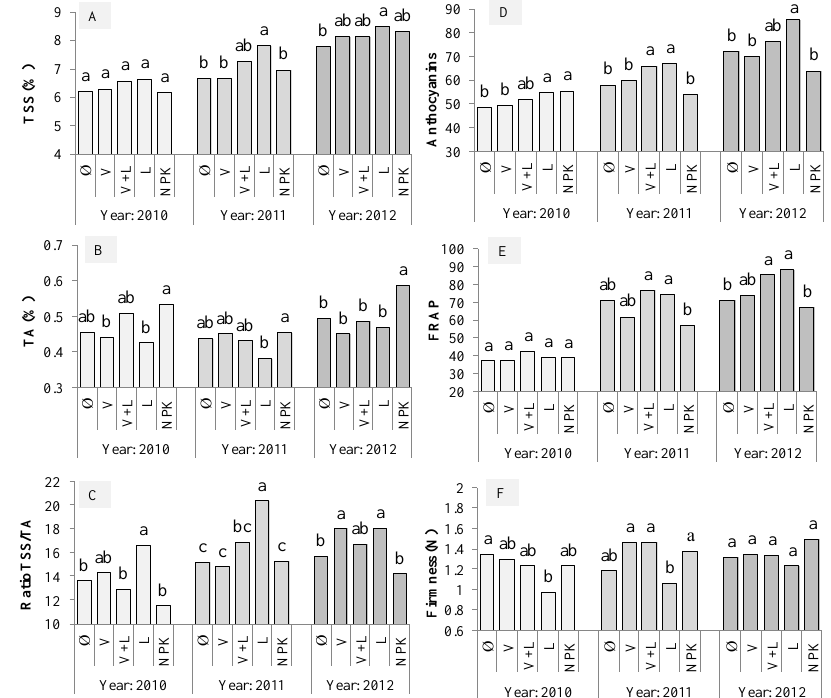
cyanins and antioxidant activity of the fruit (FRAP) not only in the control but also in the NPK treatment. On the other hand, the lowest firmness of strawberry fruit in all three years was measured on the treatment where vermicompost leachate was applied (L treatment). Strawberry fruit quality parameters in treatment V, in all three years of fruiting, did not differ significantly compared to the control treatment without fertiliza- Ø, control; V, vermicompost; V + L, vermicompost + leachate; L, leachate; NPK, mineral fertilizer. Different letters tion. denote a significant difference at p < 0.05 for each year separately.